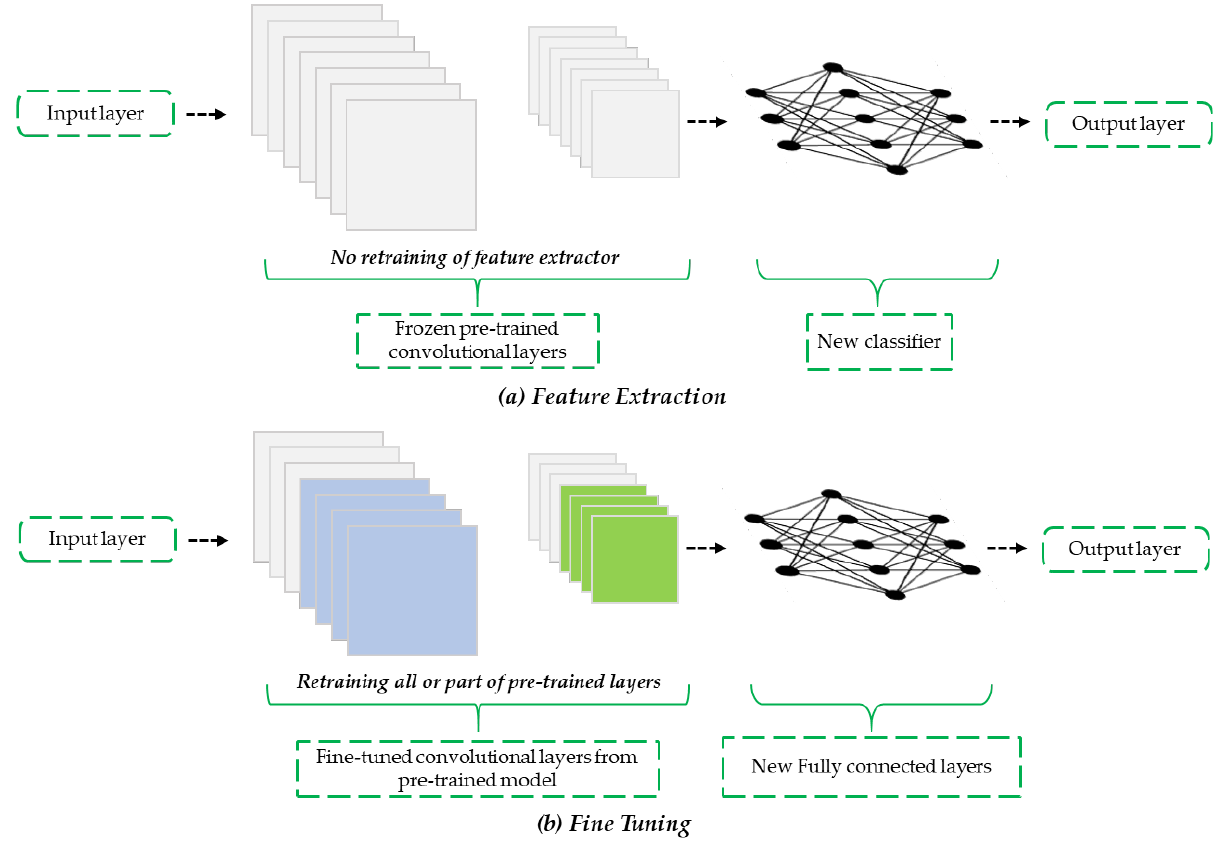
Figure 3. Procedure for TL using ( a ) FE and ( b )